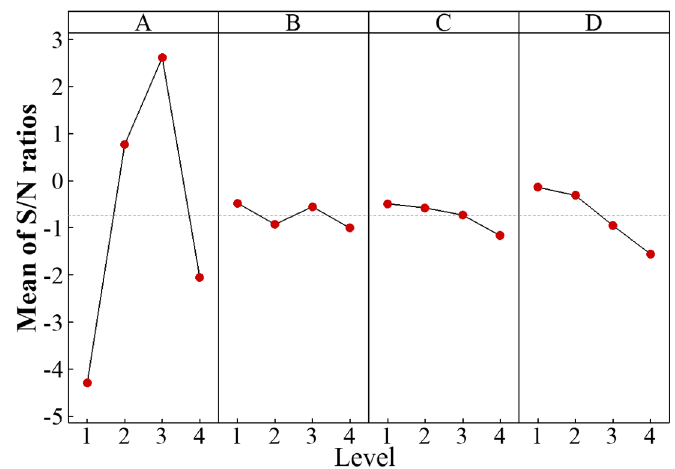
Figure 8. Profile of mean S/N ratio value.